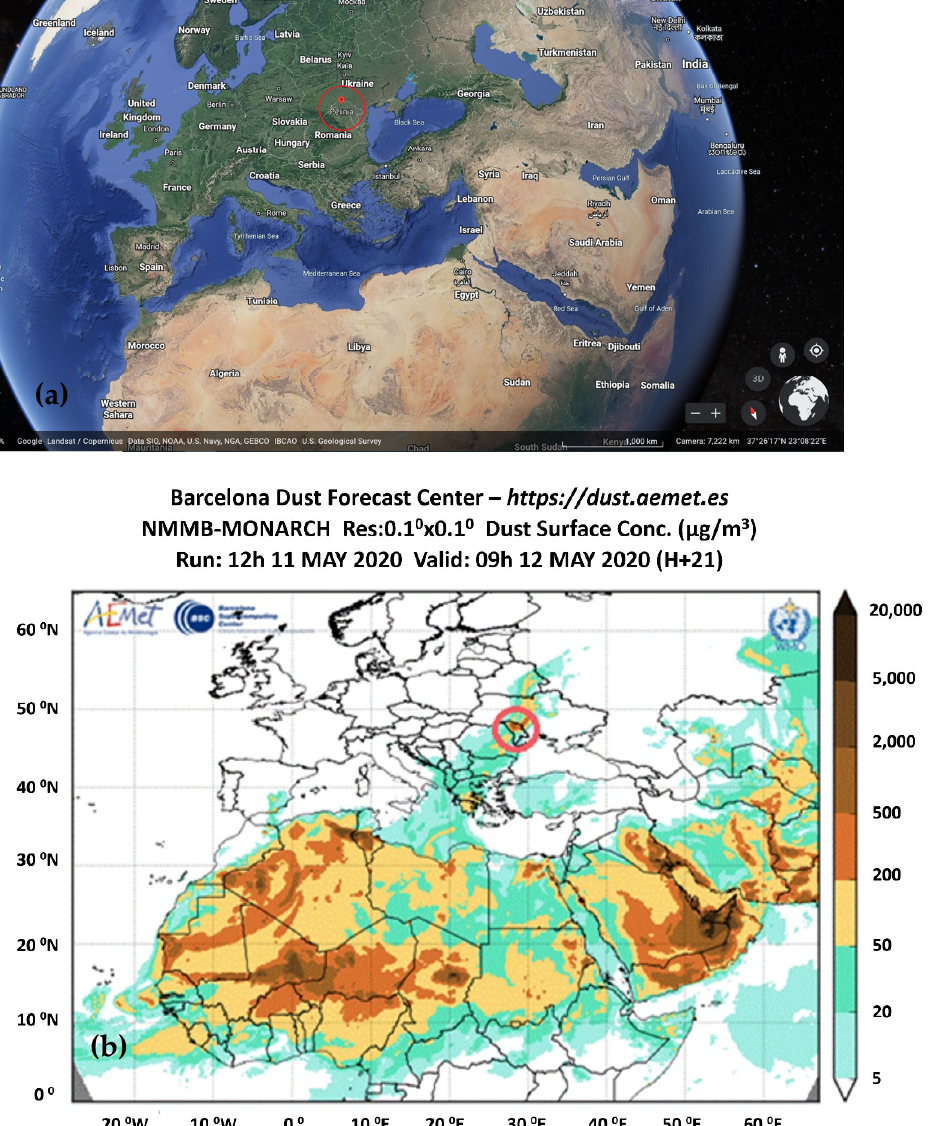
Figure 1. ( a ) Geographical position of Pelinia village, Republic of Moldova. ( b ) Presence of Saharan dust particles over Republic of Moldova (12 May 2020) [28].